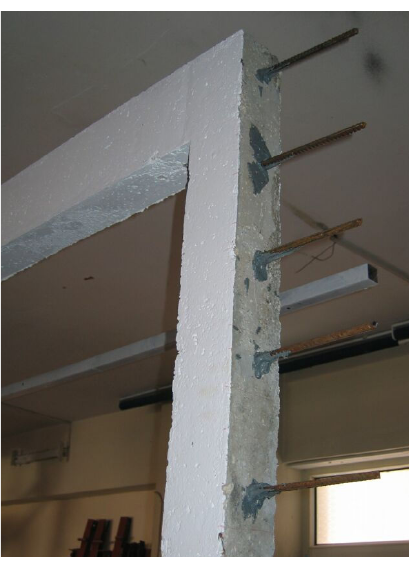
Figure 2. Properties of anchor dowels Fig. 2. Properties of anchor dowels (Arslan et al., 2010). via Loadcell and displacements via LVDT (Linear